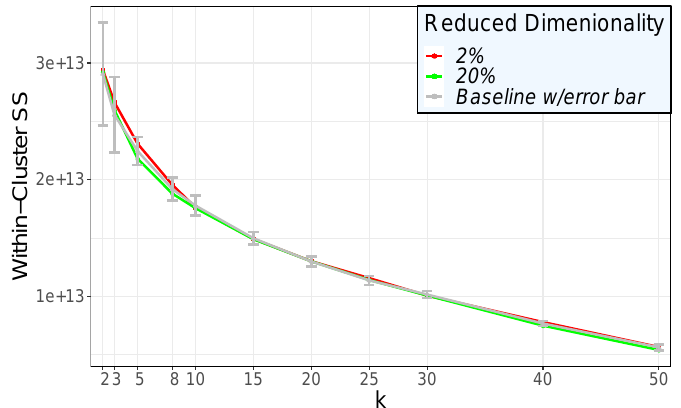
Figure 2. WCSS of initial centers with the GLI-85 Dataset.